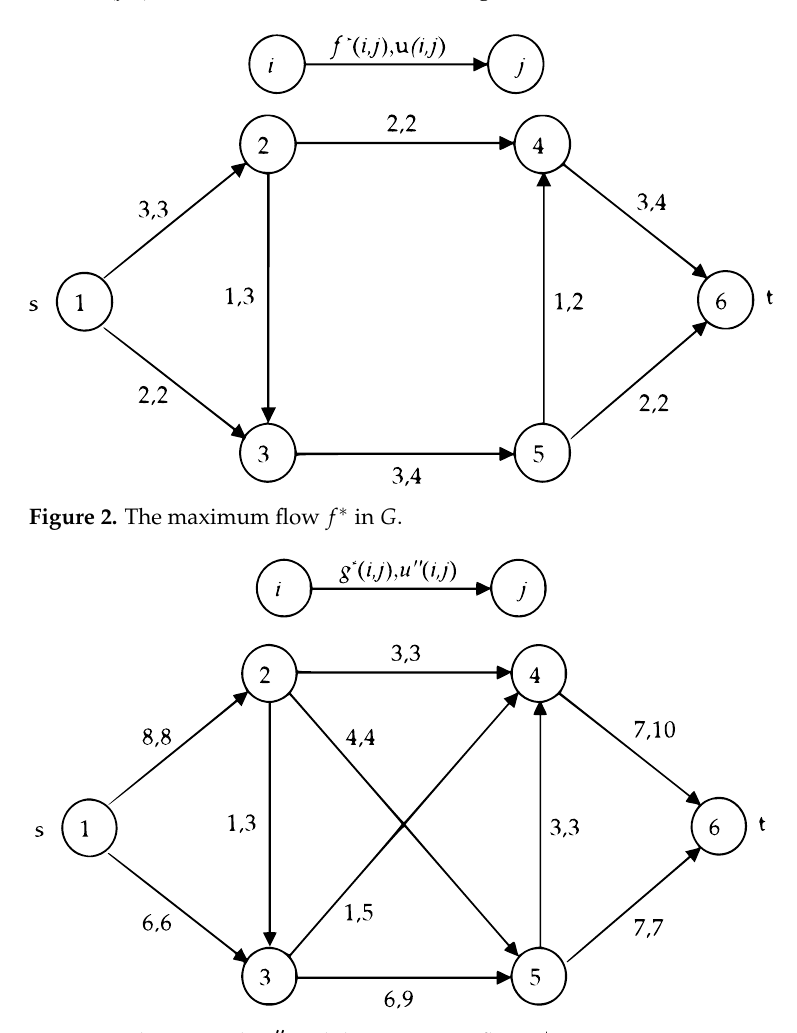
Figure 3. The network G (cid:48)(cid:48) and the maximum flow g ∗ . The maximum flow g ∗ in G (cid:48)(cid:48) has the value v ( g ∗ ) = 14 > w . Thus, MCNEP is